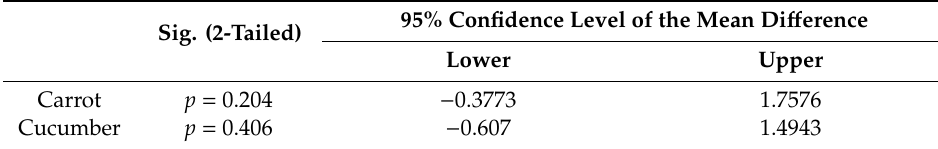
Table 1. The paired t-test between our proposal and water displacement.